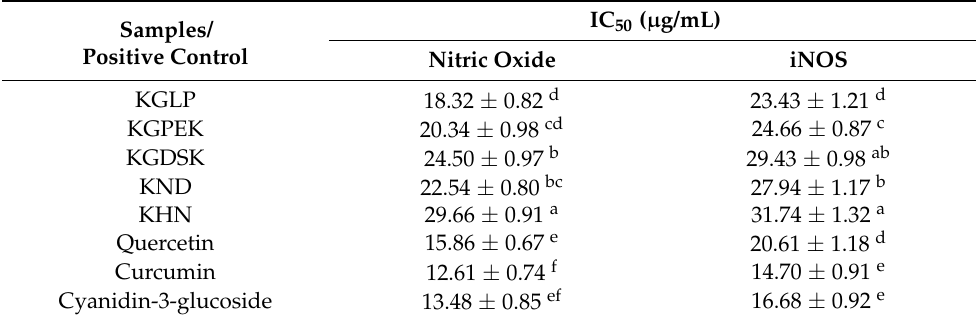
Table 4. IC 50 on inhibition effect on nitric oxide and iNOS